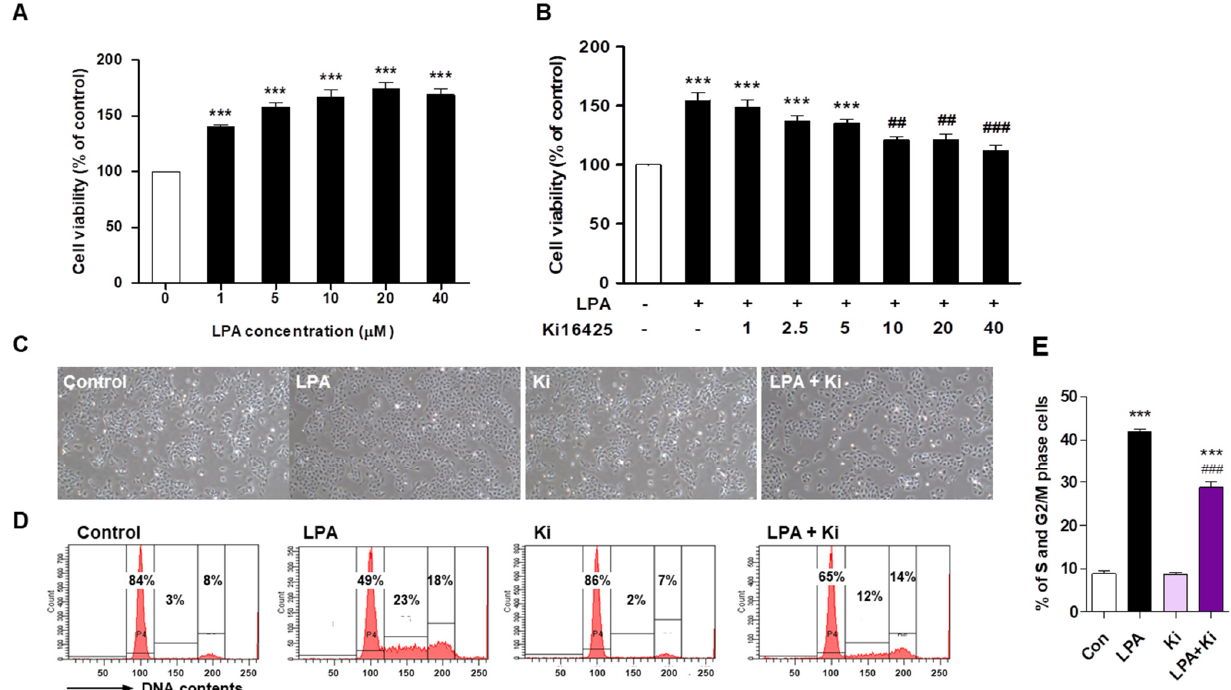
Figure 3. Ki16425 decreases lysophosphatidic acid (LPA)-induced HaCaT cell proliferation. HaCaT cells were seeded and starved in serum-free media containing 0.1% fatty-acid-free bovine serum albumin (FAF-BSA) for 12 to 16 h. ( A ) The cells were treated with 1, 5, 10, 20, and 40 μ M LPA for 24 h, and cell viability was analyzed by CCK8 assay. ( B ) The cells were treated with or without 10 μ M LPA and indicated ki16425 concentration for 24 h, and cell viability was examined by CCK8 assay. The results are presented as a percentage of control. ( C – E ) The cells were treated with 10 μ M LPA in the presence or absence of 10 μ M ki16425 for 24 h. ( C ) The cell morphology was observed using light microscopy. Original magnification, 100×. ( D ) Cell cycle phase distribution was analyzed using flow cytometry after staining with propidium iodide for measurement of the cellular DNA content. The values in the representative flow cytometry histograms indicate the percentages of cells in G0/G1, S, and G2/M phases of the cell cycle, in that order. ( E ) The percentage of cells in the S and G2/M phase was calculated as the sum of each phase from ( D ). The data are represented as the mean ± standard error of the mean (SEM) of results obtained from three independent experiments. *** p < 0.005 vs. Control; ## p < 0.01, ### p < 0.005 vs. LPA.